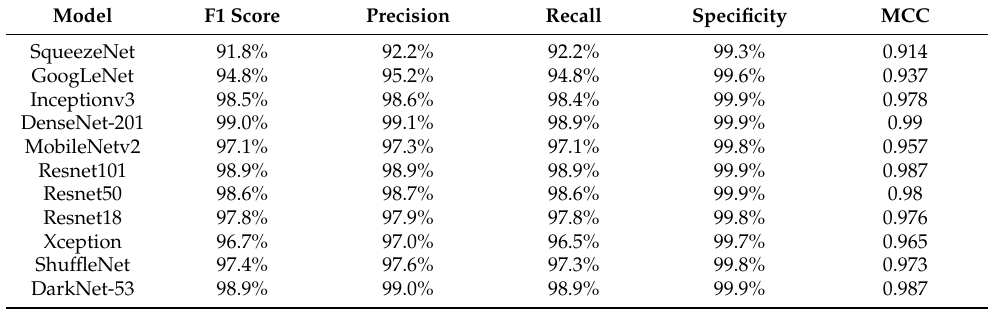
Table 2. The mean overall F1 score, Precision, Recall, Specificity, and MCC using 70% of the data for training. The results are an average of 10 runs.